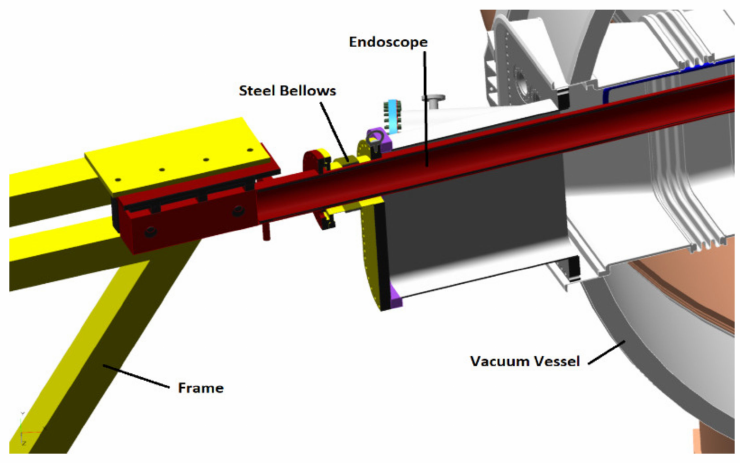
Figure 2. Representation of the connection between the diagnostic and the vacuum